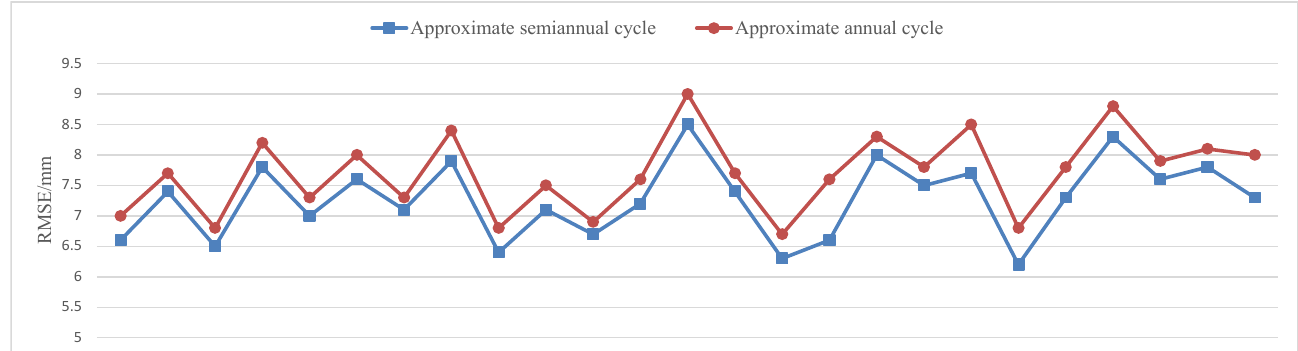
Figure 15. RMSE accuracy distribution of CORS station elevation nonlinear modeling residual prediction based on GARCH.